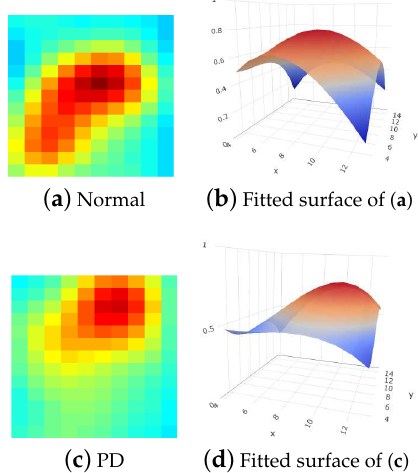
Figure 1. ( a , c ) are the 2D-combined SPECT images of a normal subject and a PD subject, respectively. ( b , d ) are the corresponding polynomial regression surfaces of order 3 for ( a , c ), respectively, obtained by Prashanth et al. [8]’s